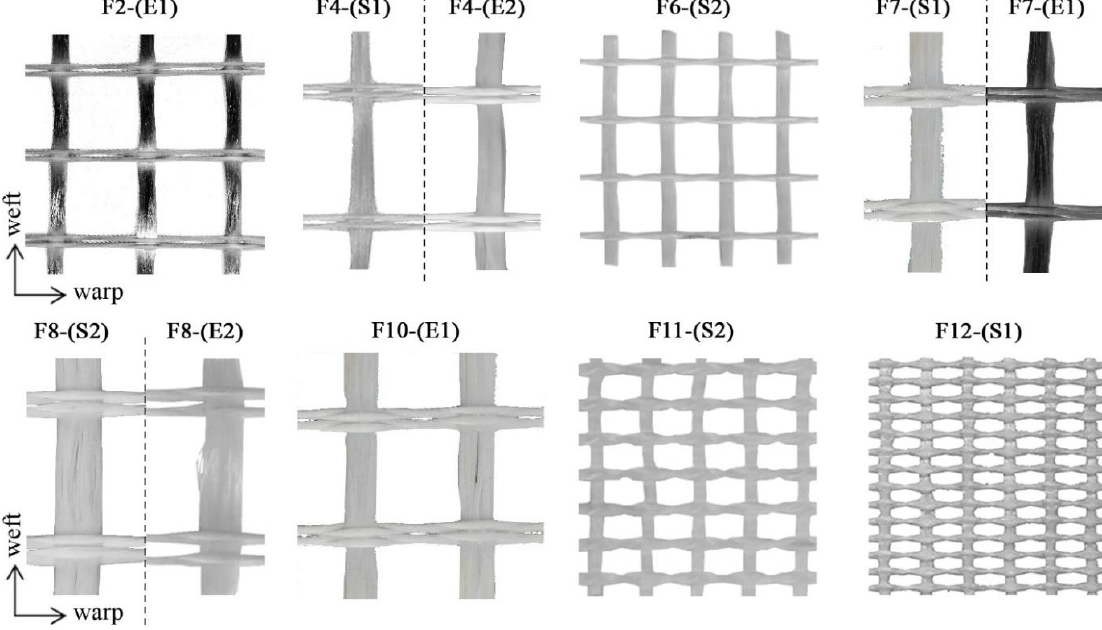
Figure 2. Overview of the some of the investigated AR-glass textiles (70 × 70 mm 2 in